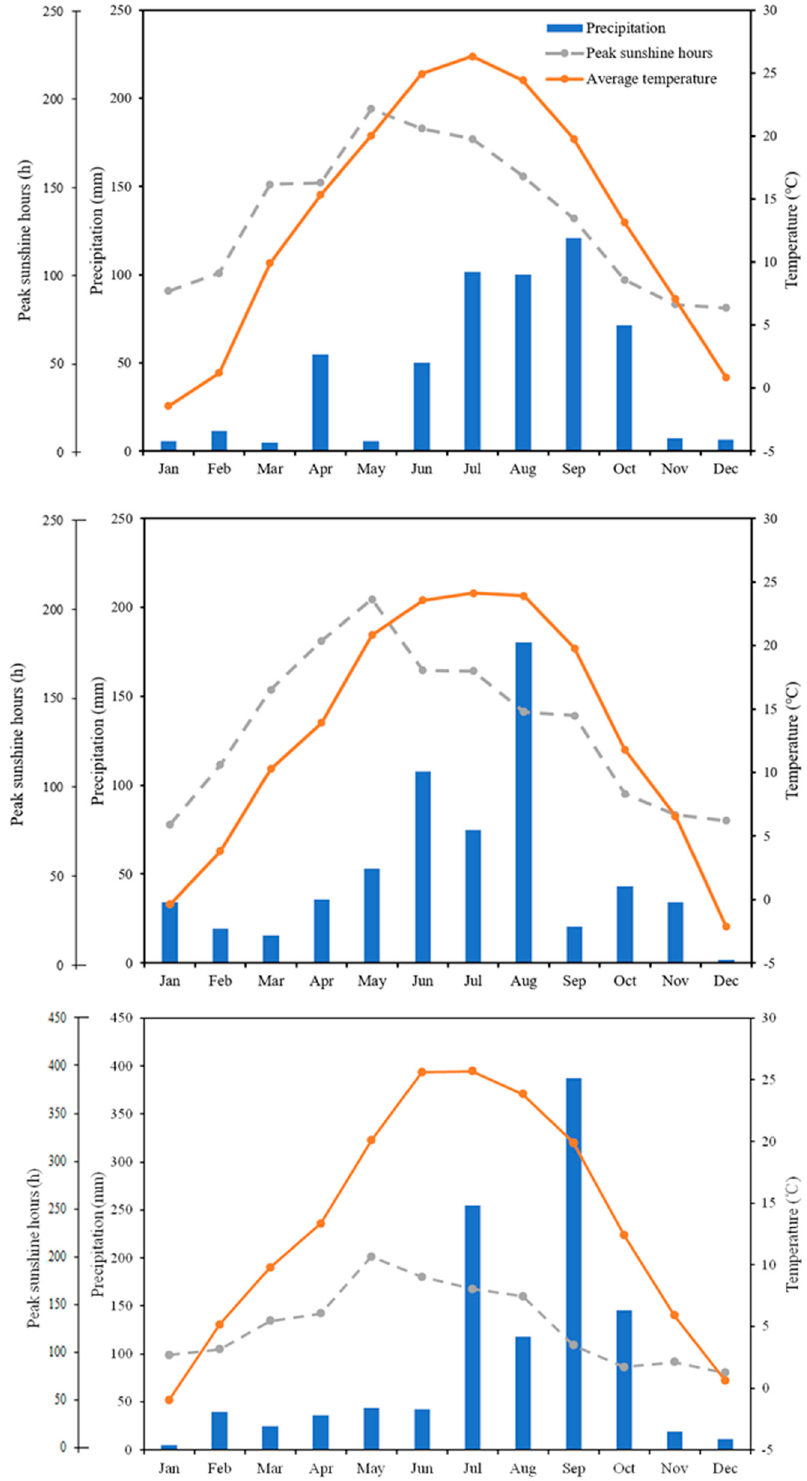
Figure 1. Monthly precipitation, peak sunshine hours, and average temperature during 2019, 2020, and 2021.